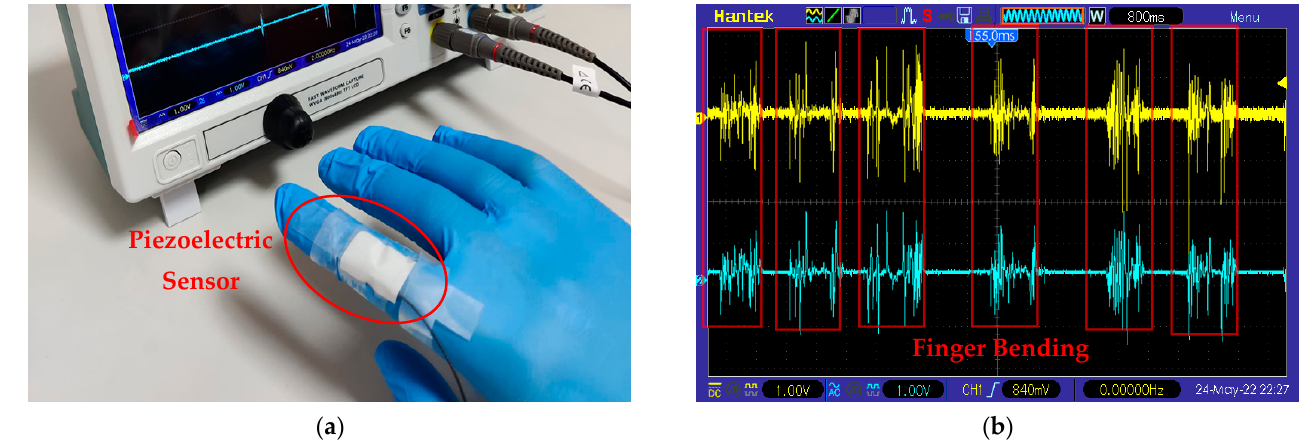
Figure 30. Application of the sensor on the index finger ( a ) and corresponding output signal V out (yellow trace) and the filtered output signal V out, filtered (cyan trace) related to finger bending ( b ).